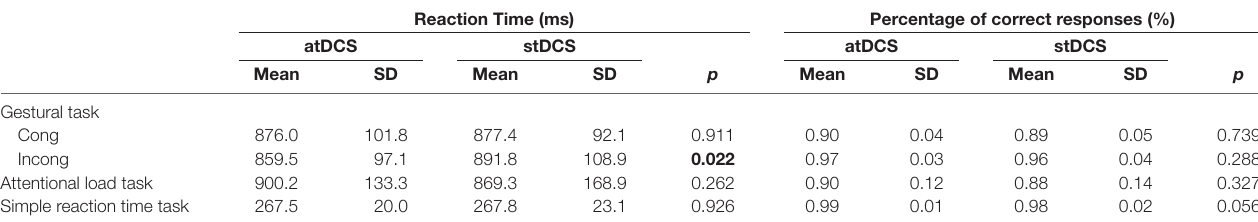
TABLE 1 | Summary of mean reaction times (RTs) and percentage of correct responses of all stimuli types in atDCS and stDCS for the gestural task, attentional load task and simple RT